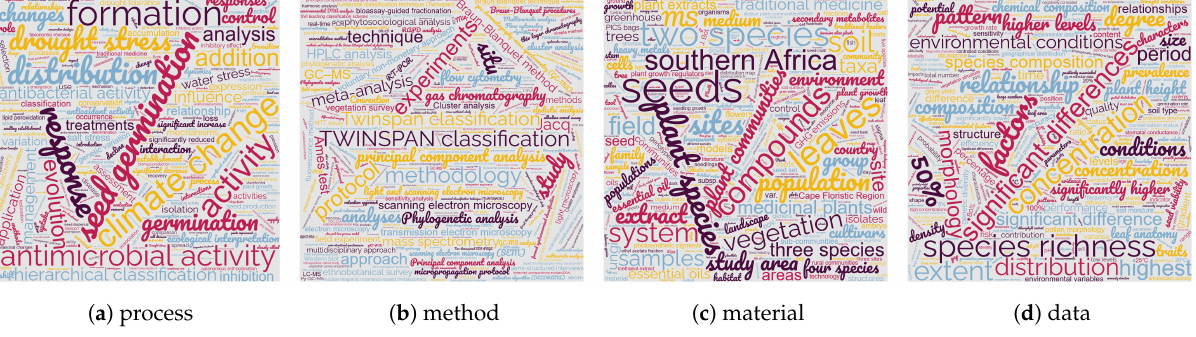
Figure 1. Agriculture domain word clouds.